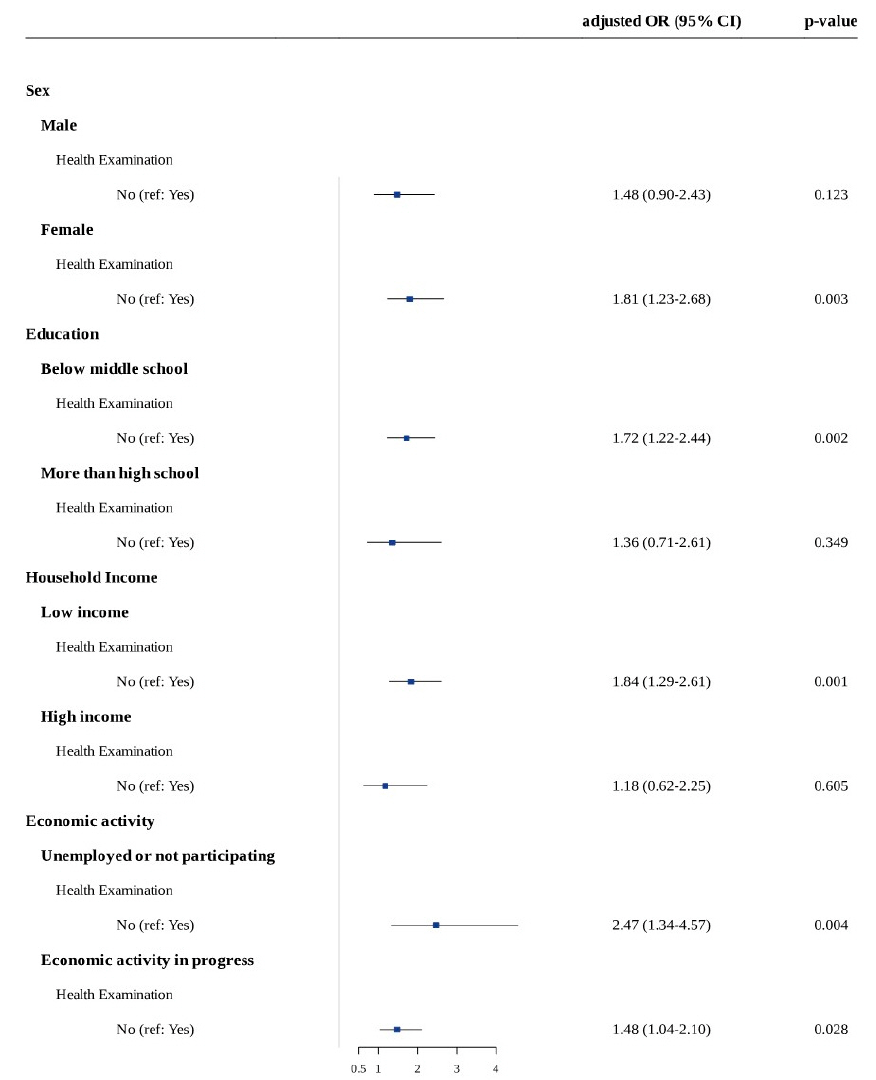
Figure 1. Forest plot of stratification analysis